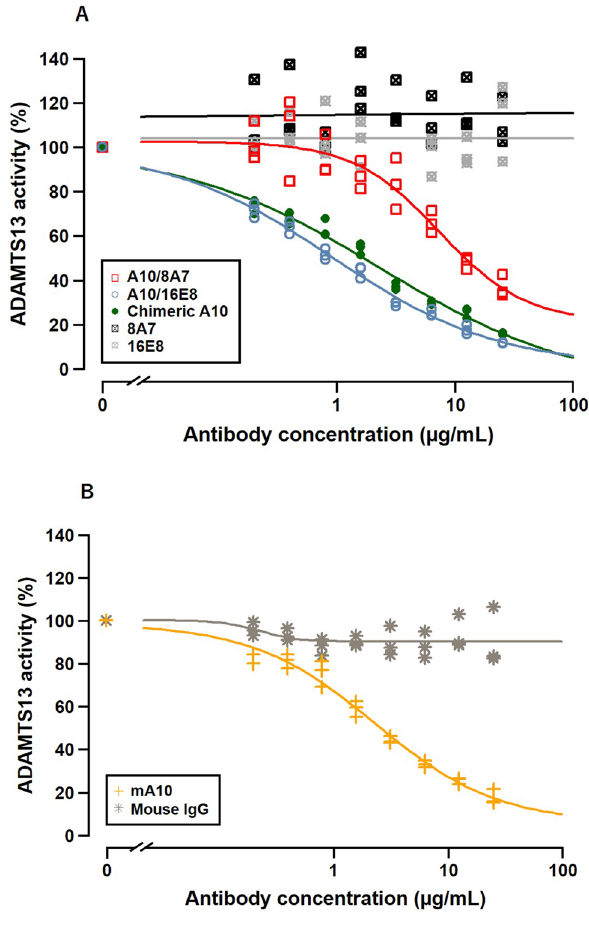
Figure 4. Monoclonal antibody concentration–response curves in vitro. The concentration-dependent ADAMTS13 inhibitory activity of human ( A ) and mouse ( B ) antibodies was determined by incubating normal pooled plasma with 2-fold serial dilutions of the antibodies ranging from 25 µg/mL to 0.20 µg/mL in triplicate. The values of dose 0 control were also measured to calculate the residual ADAMTS13 activity of each antibody. The horizontal axis is the concentration of antibodies used in these tests. The vertical axis is the residual plasma ADAMTS13 activity relative to the values of dose 0 control.